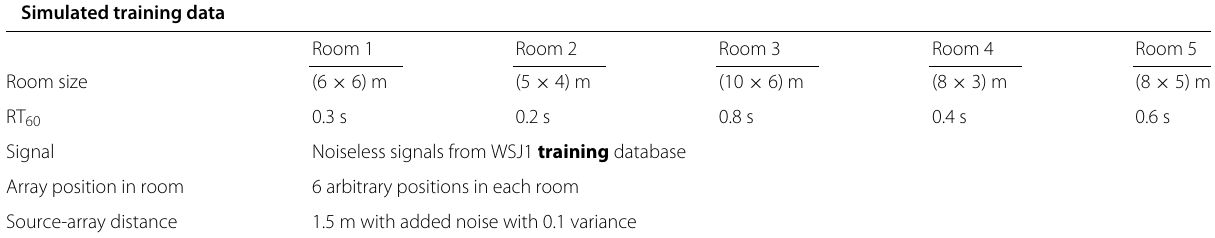
Table 2 Configuration of training data generation. All rooms are 2.7 m in height Simulated training